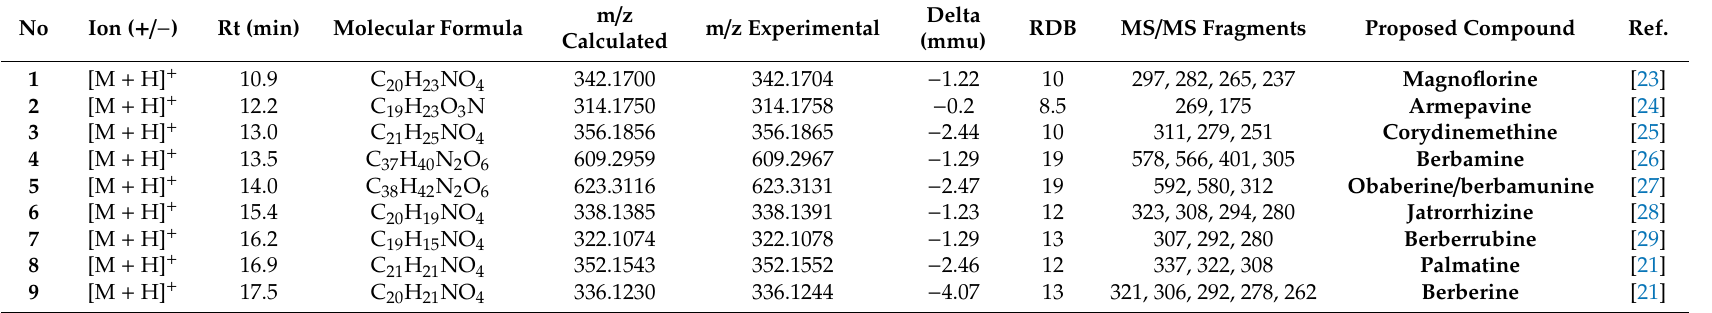
Table 1. The list of tentatively identified alkaloids in the root extract from Berberis cretica by